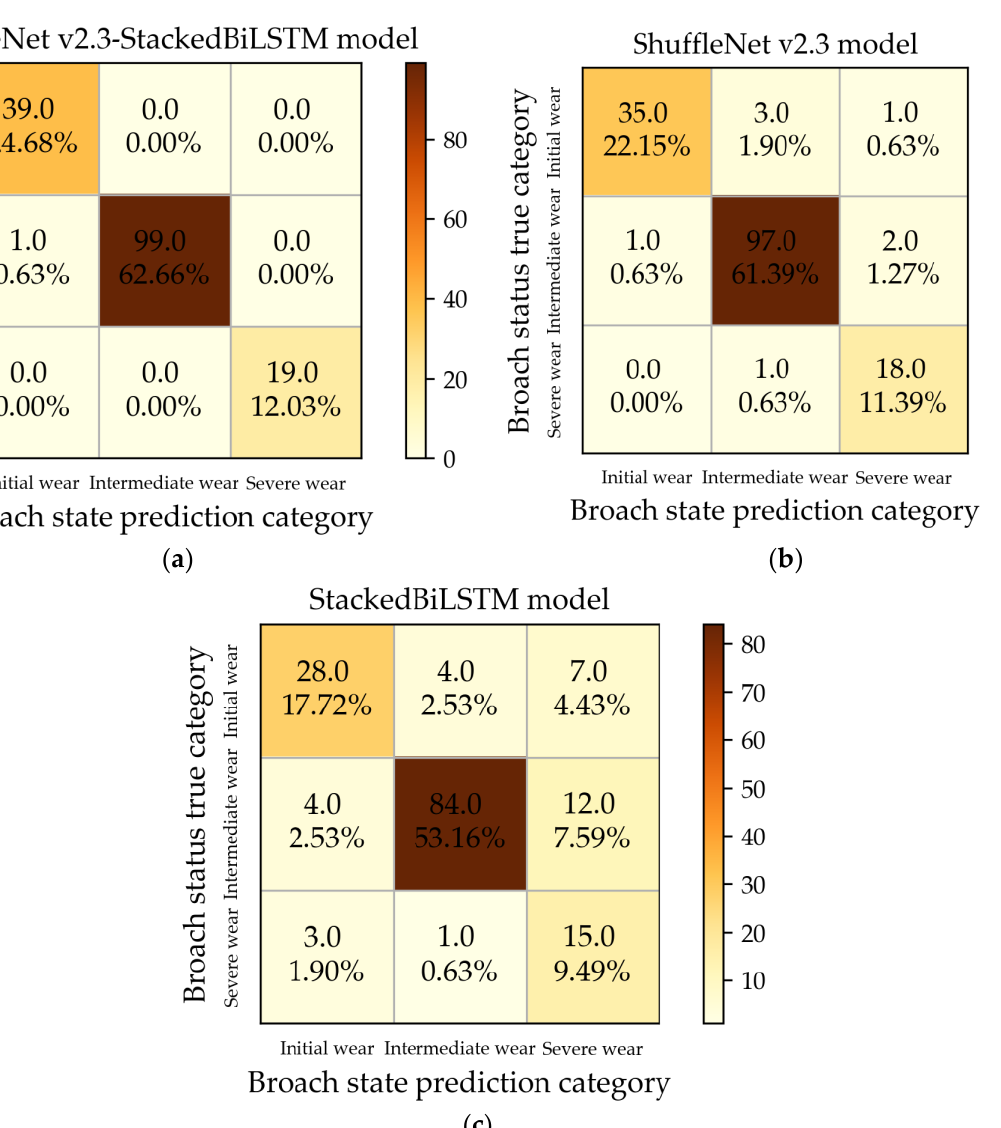
( b ) Figure 6. Loss value and accuracy change curve of each model: ( a ) Loss value curve; ( b ) accuracy curve.